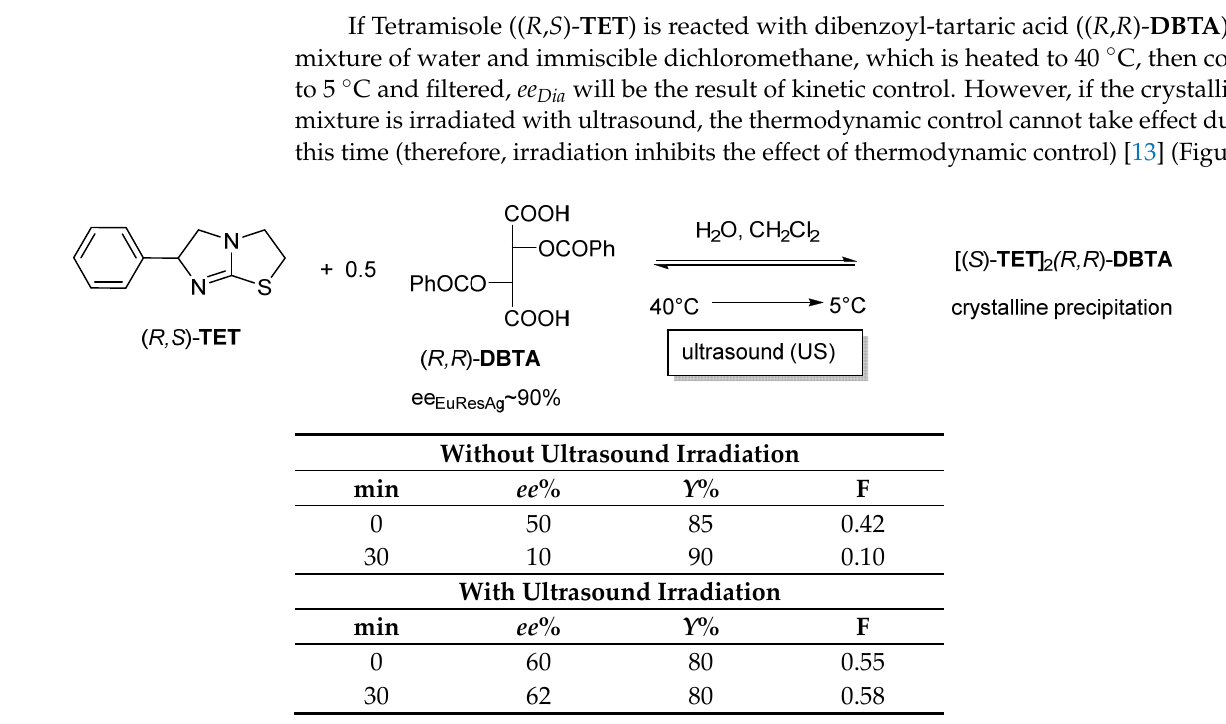
Figure 9. The enantiomeric enrichment of the TET enantiomer that can be separated from the diastereomeric salt is the result of the kinetic control, since the thermodynamic control could not exert its effect due to the ultrasonic irradiation.